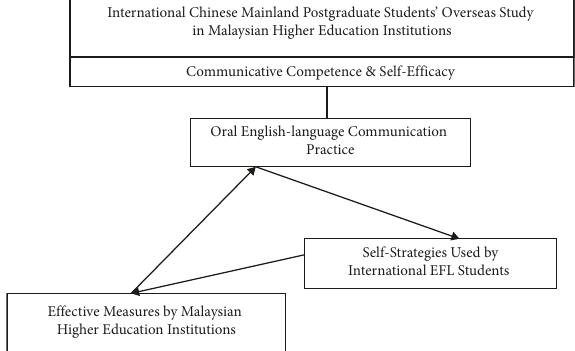
Figure 1: Conceptual framework based on communicative com- petence theory and self-efficacy